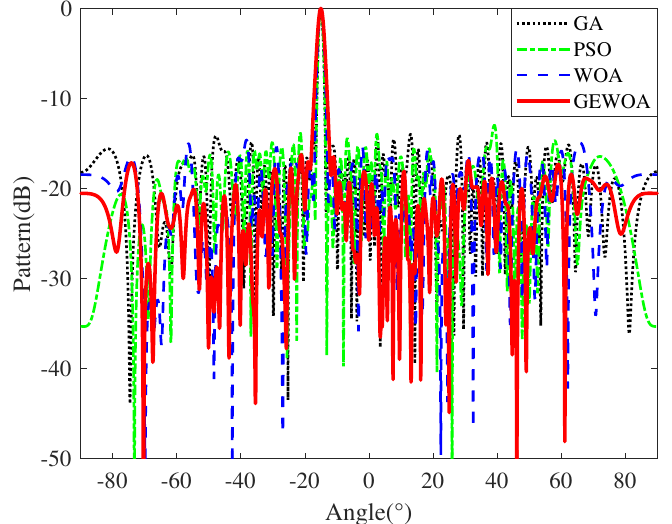
Figure 25. Beampatterns of the on-grid arrays (40-element) designed using four intelligence algo- rithms in the marine